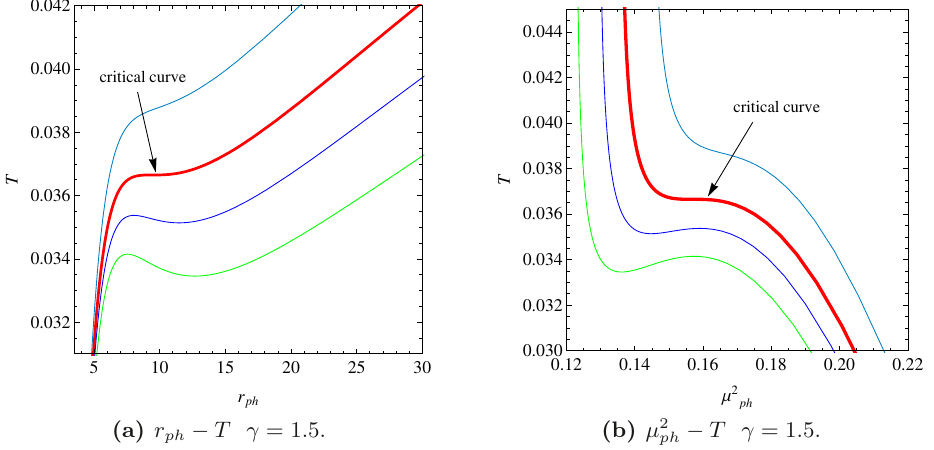
Figure 7. The YM charge set to q = 1 . 9. The pressure varies from P c from bottom to top.